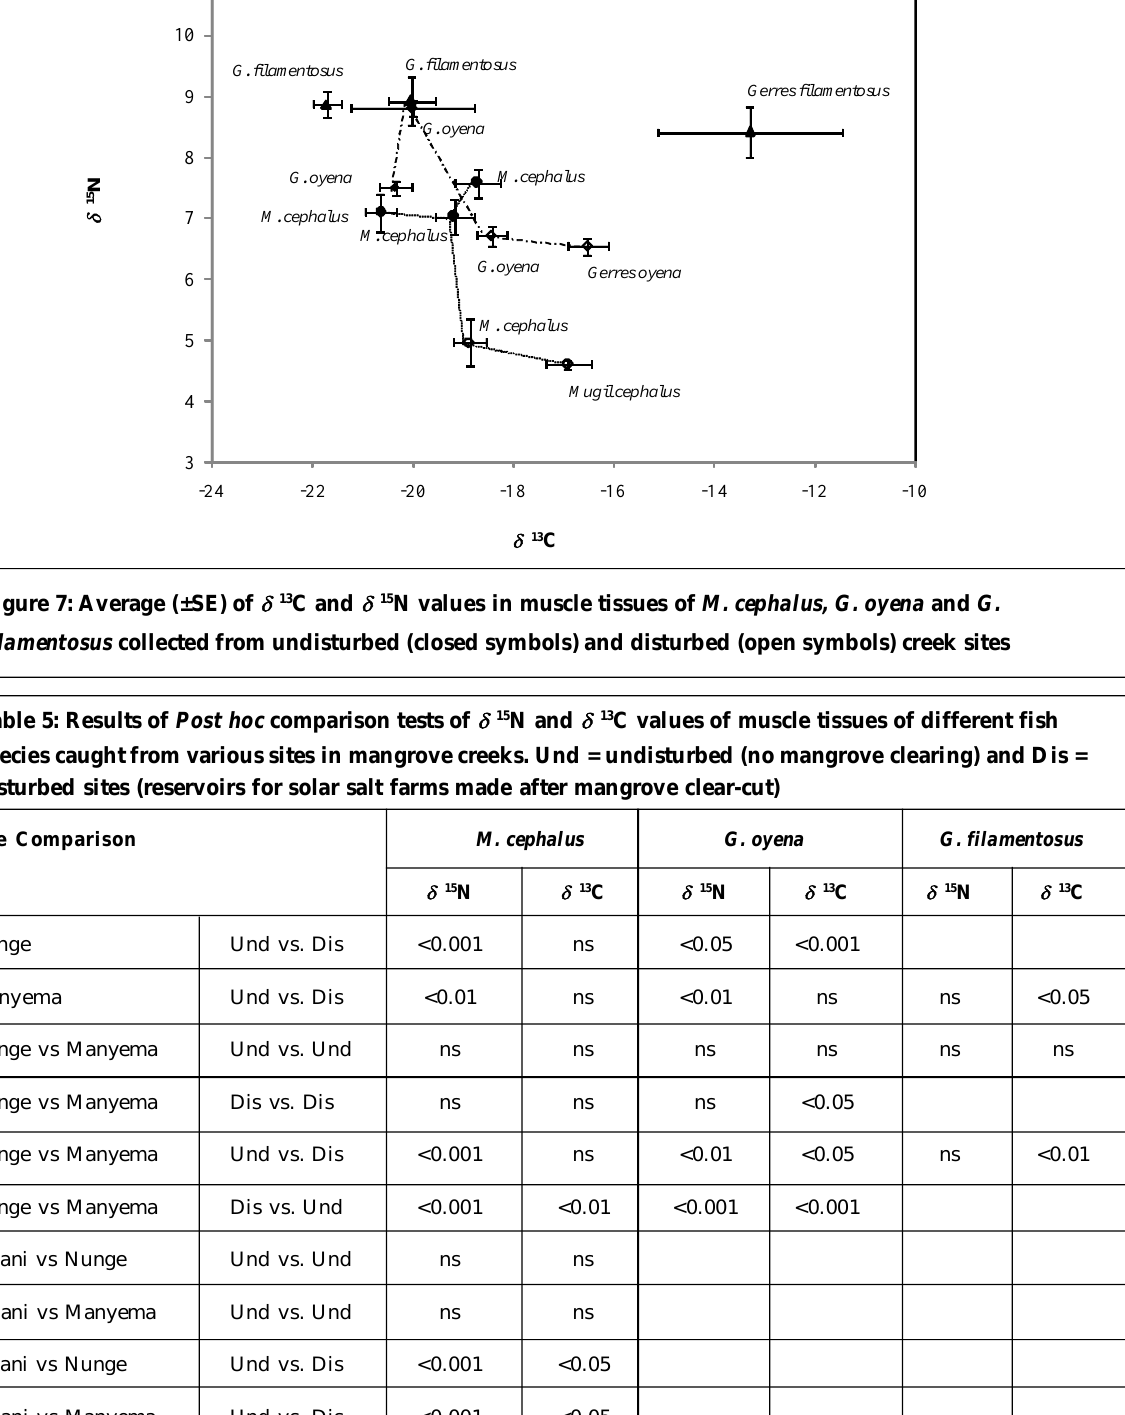
Note: ns = not significant at p